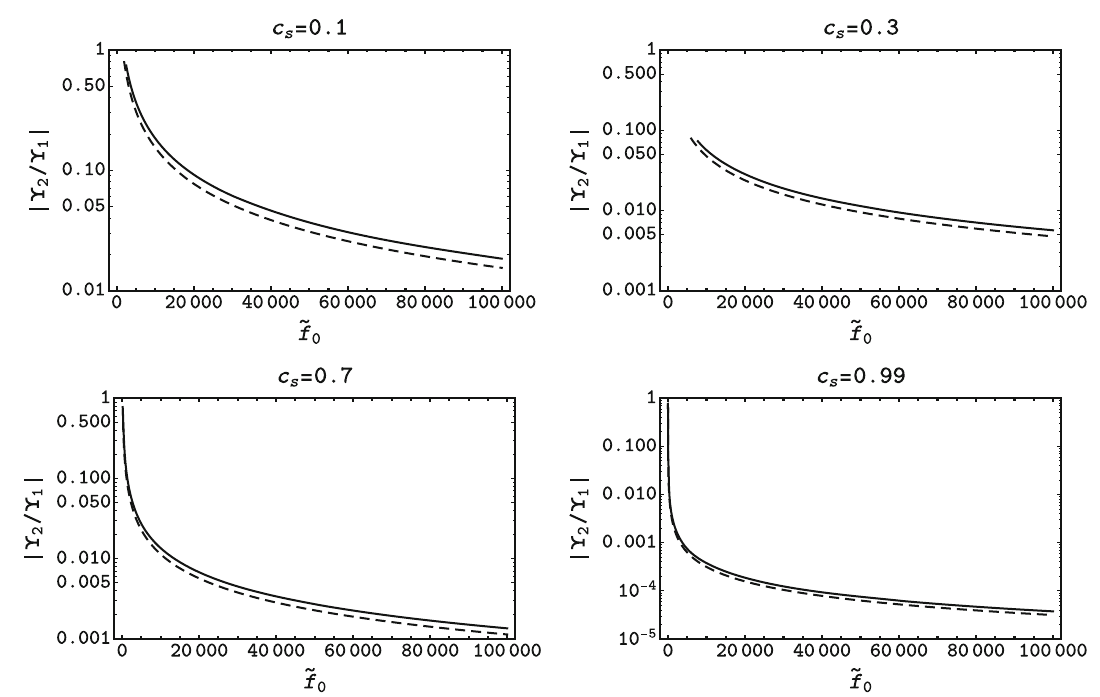
Fig. 7 The variations of | ϒ 2 /ϒ 1 | versus ˜ f 0 for different sound speeds c s = ( 0 . 1 , 0 . 3 , 0 . 7 , 0 . 99 ) . The dashed and solid lines correspond to N ∗ = 50 and 60,